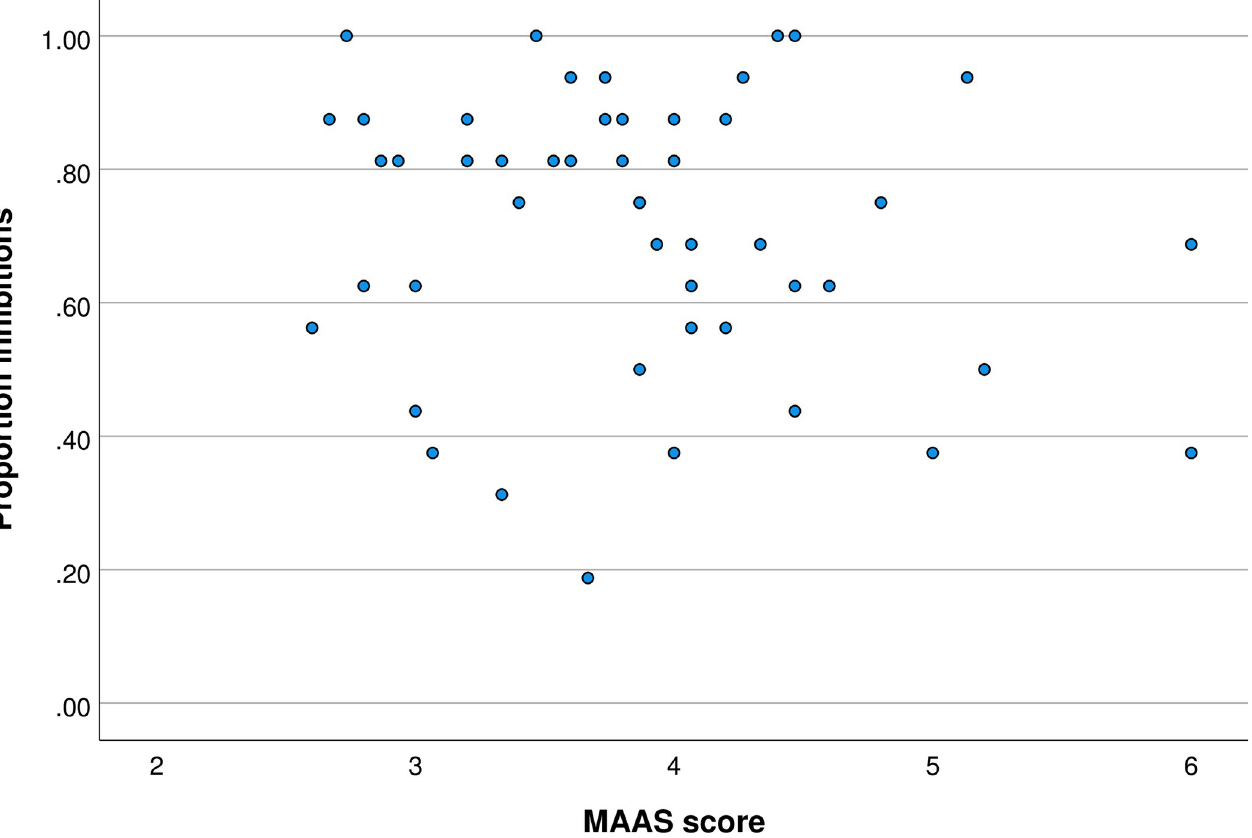
Fig 1. MAAS score and proportion inhibitions in the neutral